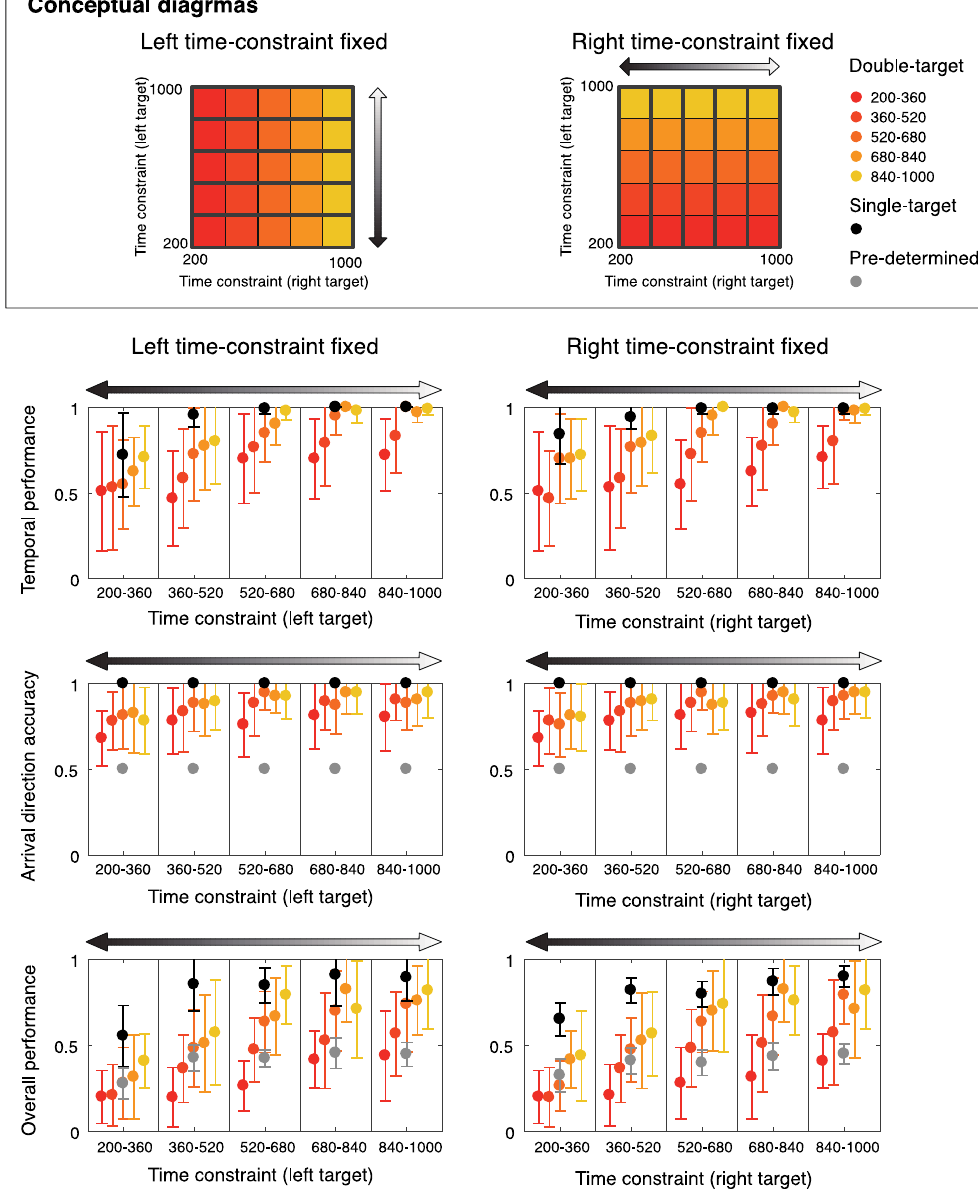
Figure 6. Comparison of performance (temporal accuracy, arrival target accuracy, overall performance) among conditions. The upper, middle, and lower panels show inter-condition comparisons of the temporal accuracy, arrival target accuracy, and overall performance, respectively. The circles and error bars show the mean and standard deviation, respectively. The black-colored circles show the data for the single-target condition. The gray-colored circles show the estimated performance of predeterminant strategy based on the data in the single-target condition. The gradient circles from red to yellow show the data for the double-target condition. The horizontal axis of the left (/right) panel is classified by the level of time constraint of the left (/right) target, and the modulation according to the time constraint of the right (/left) target at each time constraint level is shown as a gradient. The color changes from red to yellow, depending on the severity of the time constraint of the other target (red is tight, yellow is loose). In tight time-constraint condition (the leftmost time constraint level in each panel), the temporal accuracy in the double-target condition was significantly less than that in the single-target condition, and the arrival target accuracy in the double-target condition was significantly higher than the performance of predeterminant strategy estimated from the data of the single-target condition (gray- colored circles and lines). Additionally, in tight time-constraint condition (the leftmost time constraint level in each panel), the overall performance in the doubl-target condition was significantly less than the performance of the predeterminant strategy (gray-colored circles and lines). This deficit in performance may be due to excessive preference for the choice reaction even in the tight time-constraint